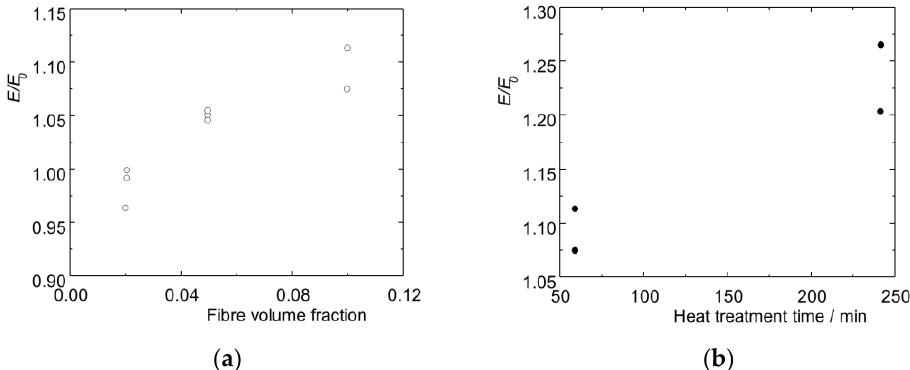
Figure 17. ( a ) Dynamic Young’s modulus of heat-treated C/TiC/Ti composites, normalized by that of the same composites before heat treatment versus the initial fibre volume fraction. The heat treatment regime was 1075 ◦ C–60 min. ( b ) Normalized dynamic modulus of C/TiC/Ti composites with initial fibre volume fraction of 10% heat treated at 1075 ◦ C versus the heat treatment